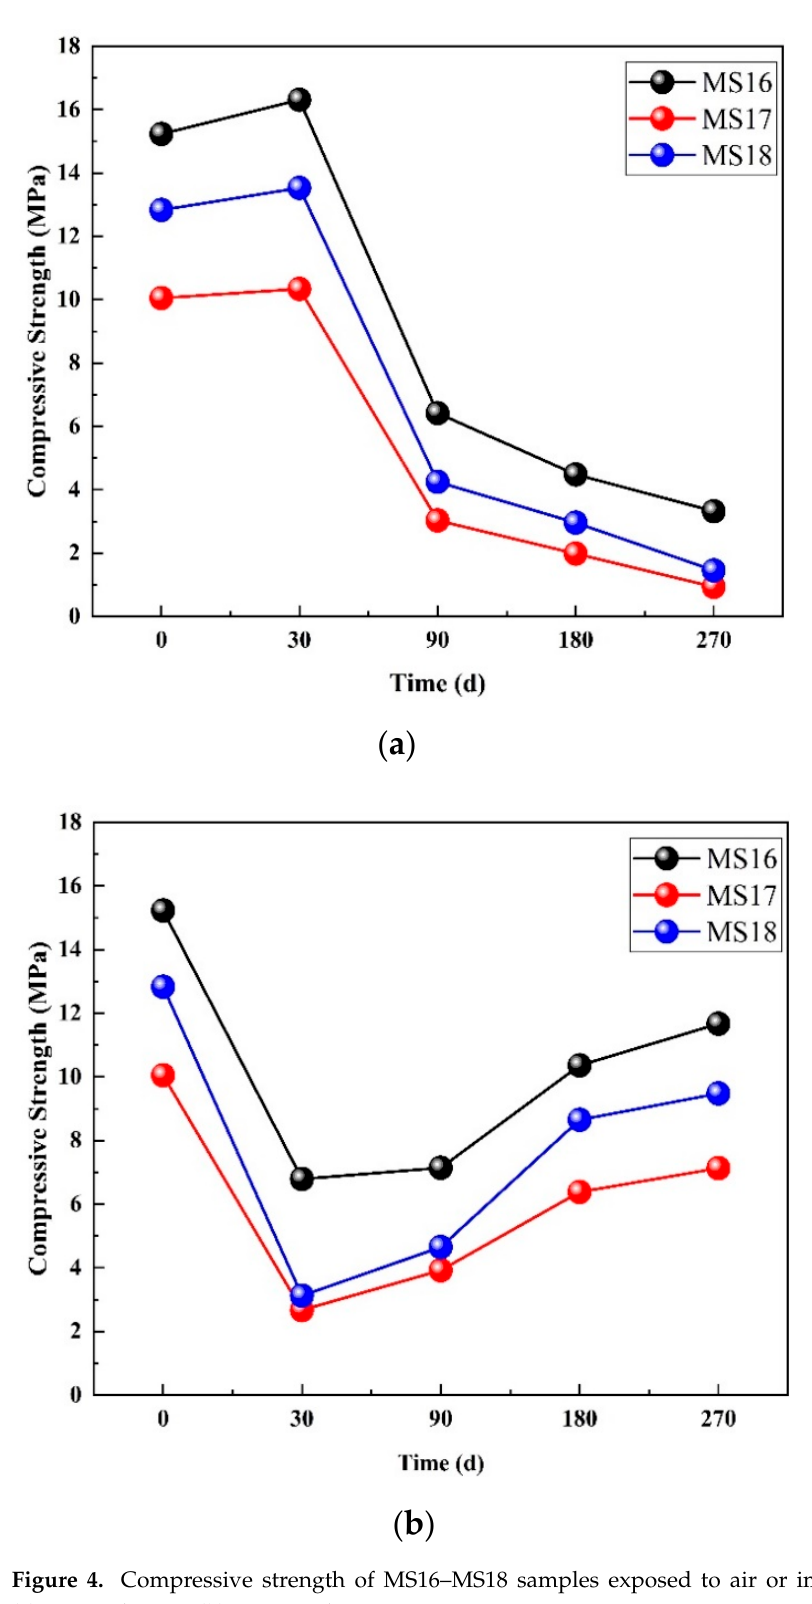
Figure 4. Compressive strength of MS16–MS18 samples exposed to air or immersed in water. ( a ) Exposed to air. ( b ) Immersed in water.